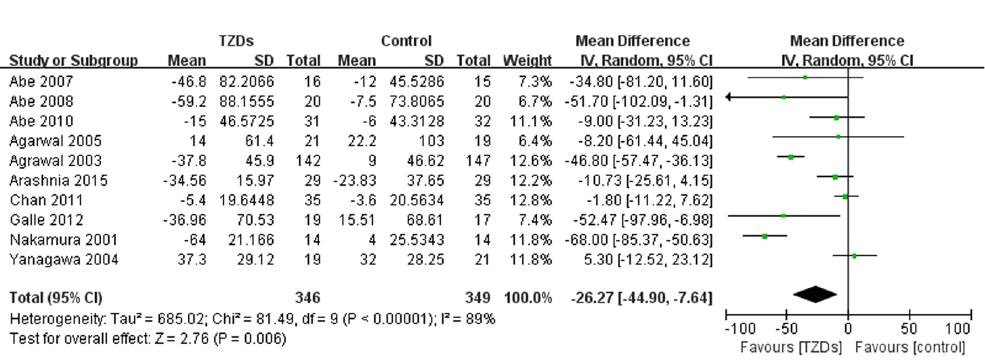
Figure 3. Change in FPG among patients with diabetes mellitus and renal impairment receiving TZDs versus control from